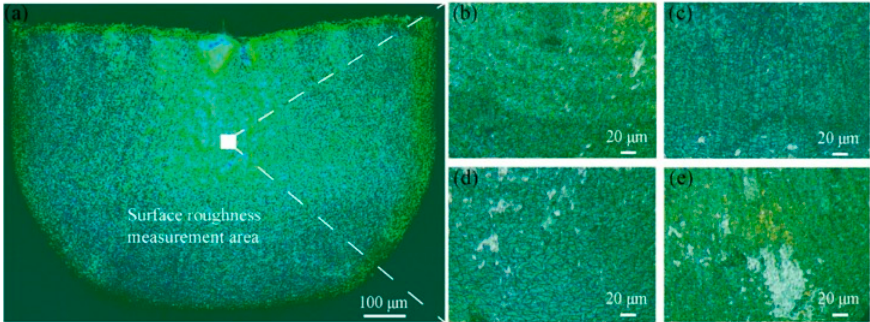
Figure 9. ( a ) The selected area on the cup for surface roughness measurement; and the surface morphology of the cups from ( b ) dry; ( c ) 1 wt% TiO 2 lubrication; ( d ) 2 wt% TiO 2 lubrication; and ( e ) 4 wt% TiO 2 lubrication.